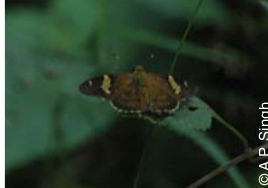
Image 132. Common Leopard, Phalantha phalantha